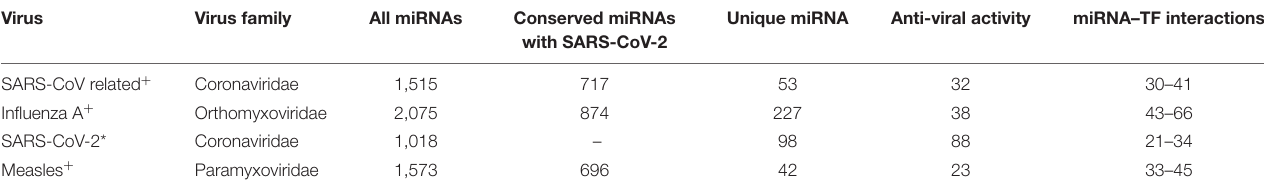
TABLE S1 | Host–SARS-CoV-2 interaction data. TABLE S2 | List of miRNA targeting host genes identified using the miRnet server. TABLE S3 | List of reported anti-viral miRna interactions. TABLE S4 | GRN